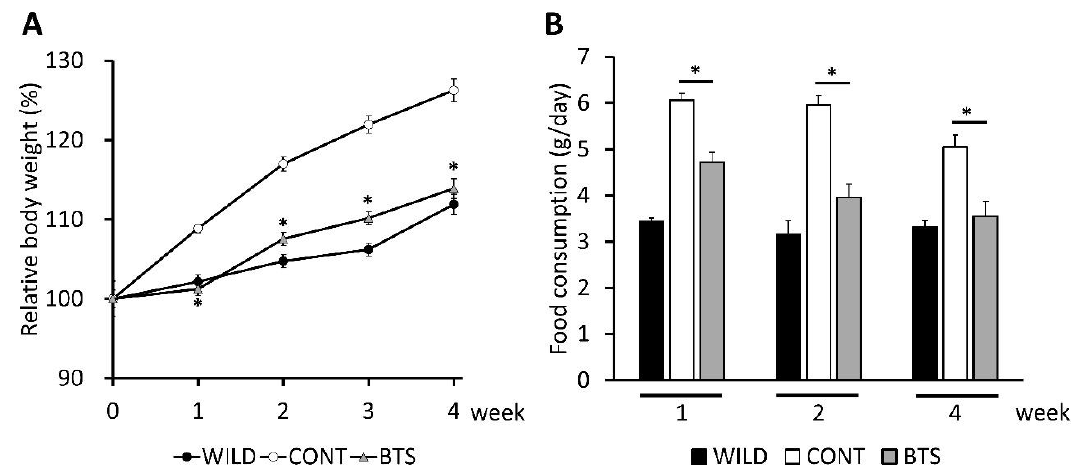
Figure 2. Effects of dietary administration of Bofutsushosan (BTS) on body weight and food intake. Seven-week-old ob / ob and C57BL / 6J mice were administered a standard diet with or without 5% (w / w) BTS for 4 weeks. (A) Change of relative body weight based on the value at Week 0. Closed circle, C57BL / 6 mice (WILD group); open circle, ob / ob mice fed a standard diet (CONT group); gray triangle, ob / ob mice fed a standard diet supplemented with 5% BTS (BTS group). Data are shown as mean ± SE ( n = 6). (B) Mice were housed two per cage. Food intake was measured per cage. Closed, open, and gray columns represent WILD, CONT, and BTS groups, respectively. Data are shown as mean ± SE ( n = 3). *; p < 0.05 by Student’s t -test with Bonferroni’s correction (CONT vs. BTS).